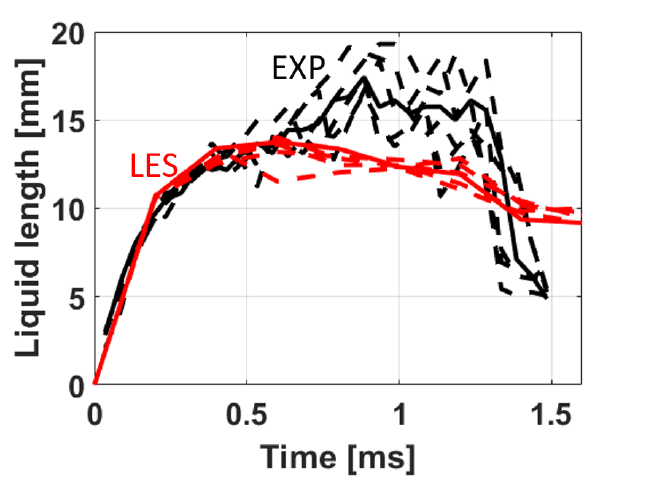
Figure 5. Liquid length comparison between the experiments (EXP) and the simulations (LES). The solid lines represent the liquid length computed using the ensemble-averaged PLV, while the dashed lines show the liquid length for individual